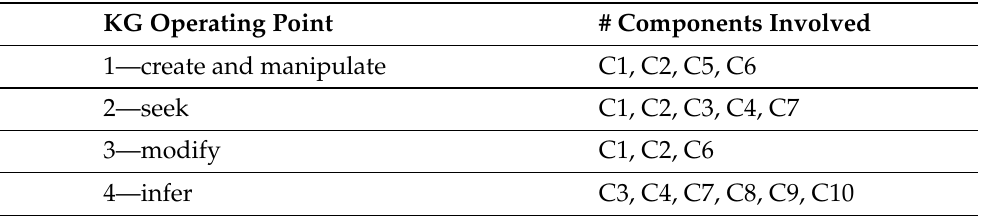
Table 1. Synthesis of how the components of the artifact are used and operated, based on Table